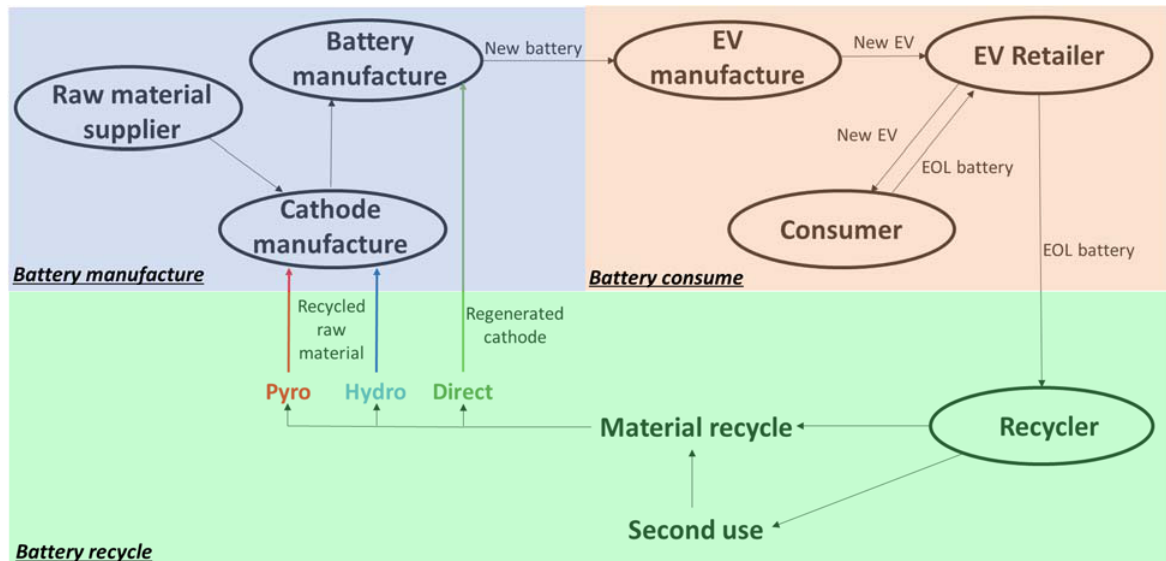
Figure 2. The circular supply chain of the battery industry including battery manufacturing, consuming and recycling.